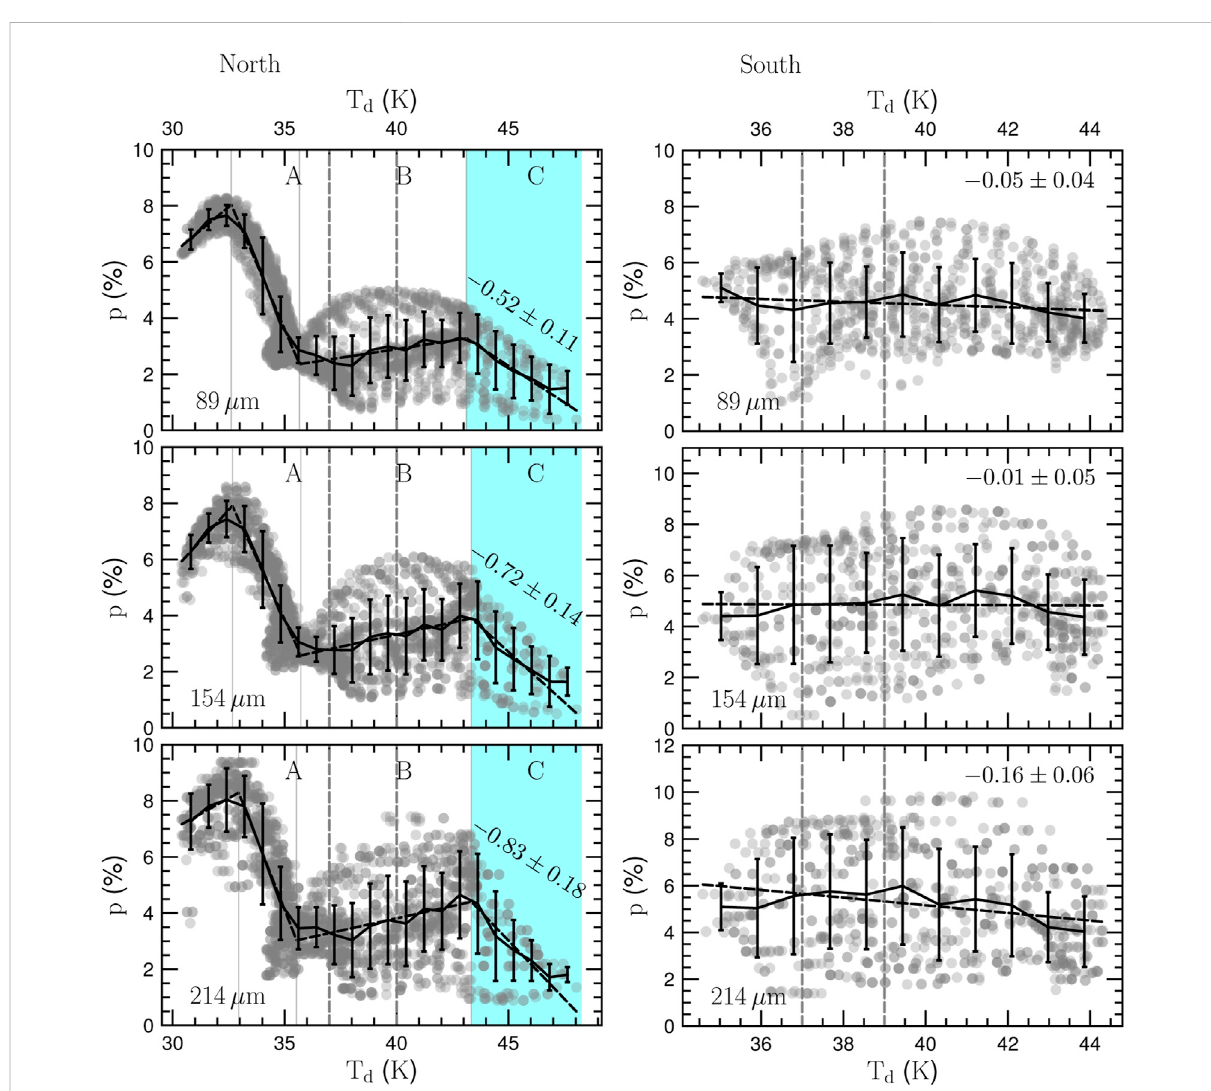
FIGURE 10 Relations between polarization degree and dust temperature in three bands (from top to bottom) in north (left panel) and south (right panel)